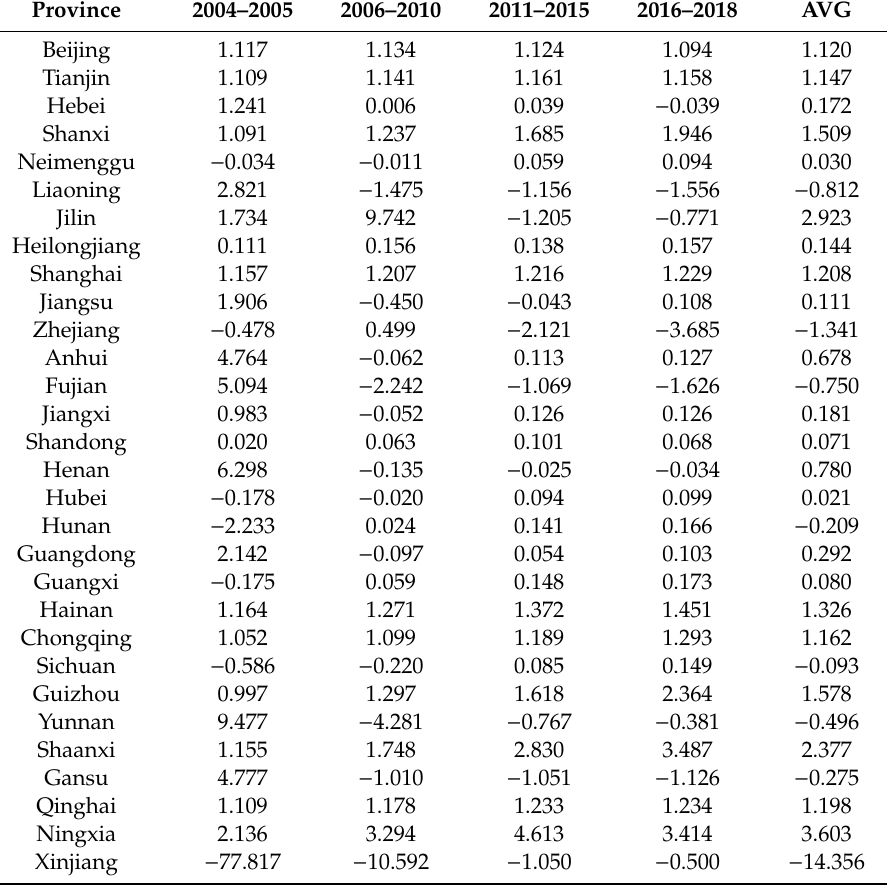
Table 6. The substitution elasticity of capital and water of 30 provinces in China